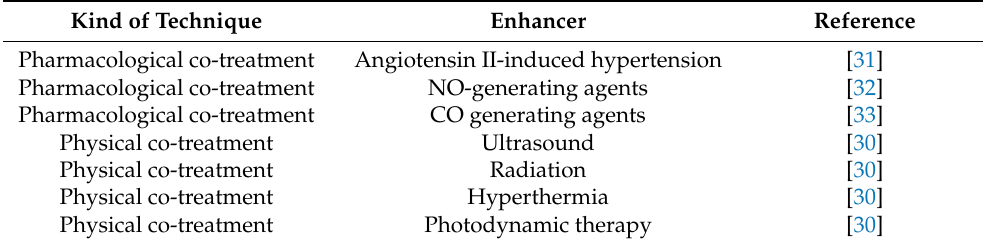
Table 1. EPR enhancers to obtain an “EPR-adaptive delivery” in nanomedicine. Kind of